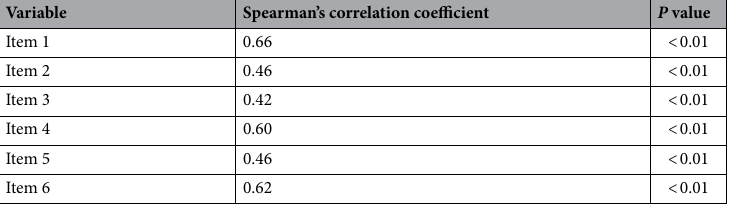
Table 6. The correlations between each item and total score of FPI-6. Total FPI-6, Foot total score of FPI-6; LOA, Limit of Agreement; MDC, minimal detectable change; SEM, standard error of measurement; Item 1, talar head palpation; Item 2, curves above and below the lateral malleolus; Item 3, a bulge in the region of the talonavicular join; Item 4, eversion and inversion of the calcaneus; Item 5, congruence of the medial longitudinal arch; Item 6, adduction and abduction of the forefoot in relation to the rear foot.